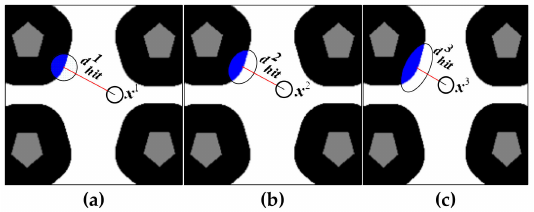
Figure 7. Changing process of Σ hit . The uncertainty of N ( µ hit , Σ hit ) is increasing as a robot moves in an ambiguous area and more particles will be generated by the portal motion